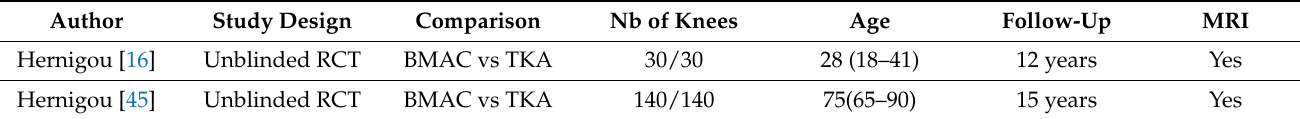
Table 2. Clinical randomized studies with BMAC subchondral